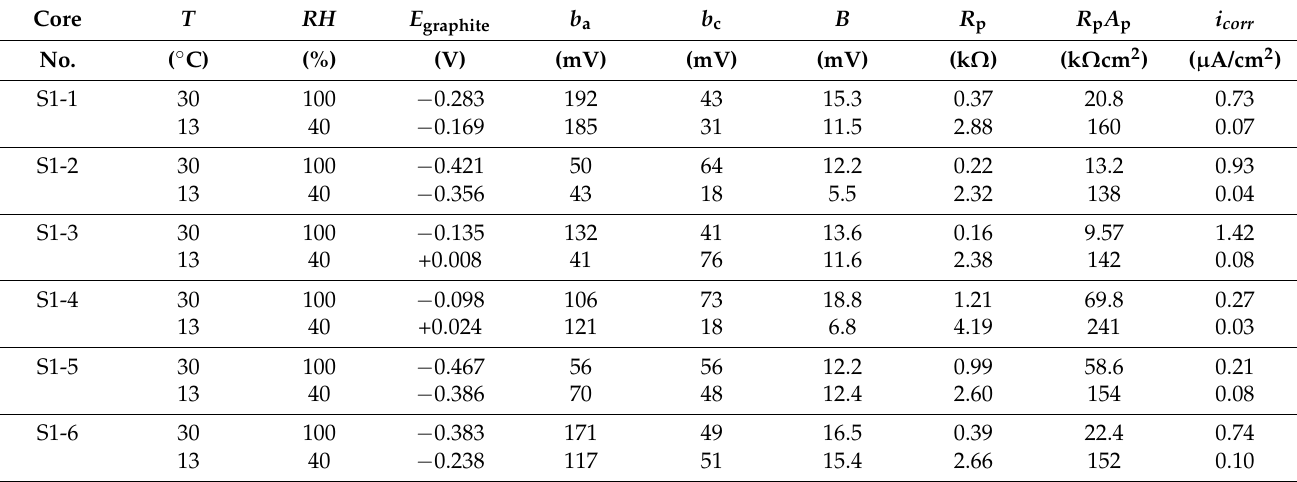
Table A3. Results of the analysis of polarization curves for steel reinforcement in cores drilled from the silo S1.